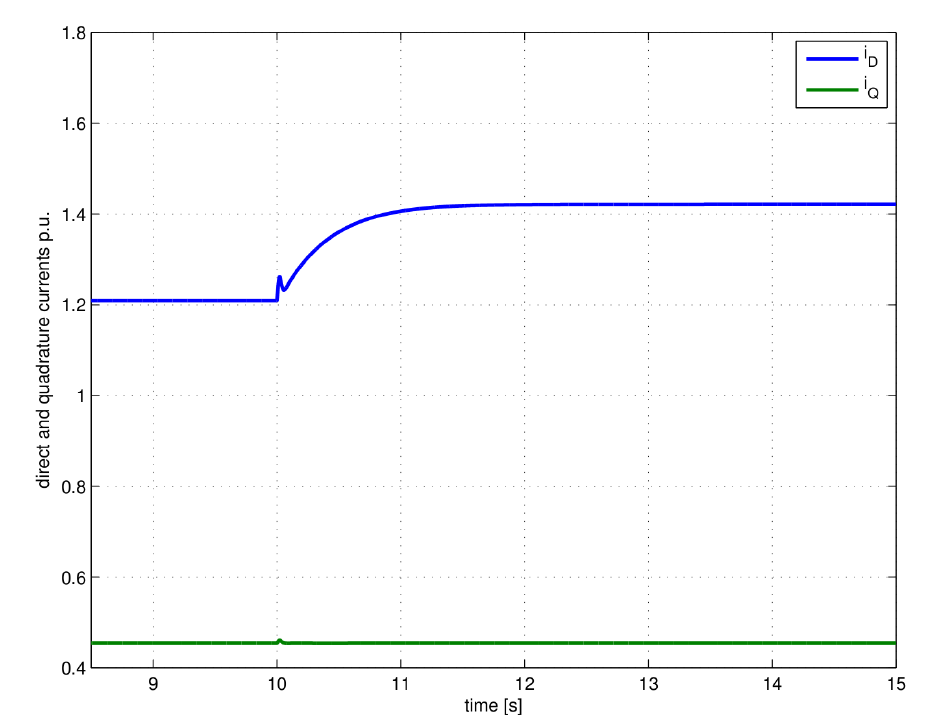
and i after the grid D Q